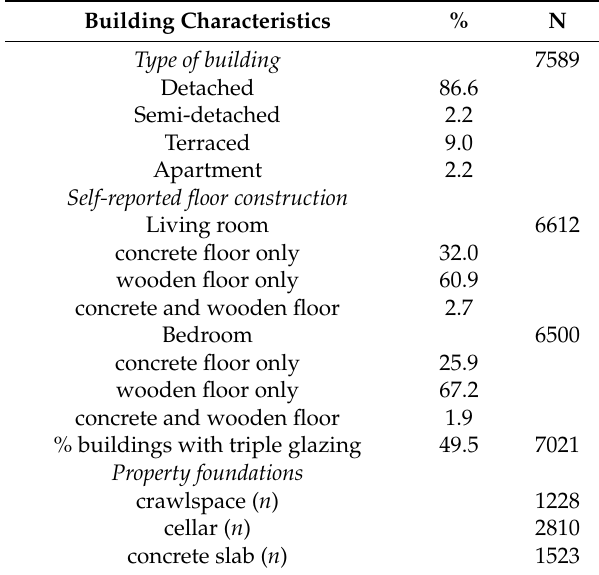
Table 2. Descriptive statistics of the houses of participants who completed a